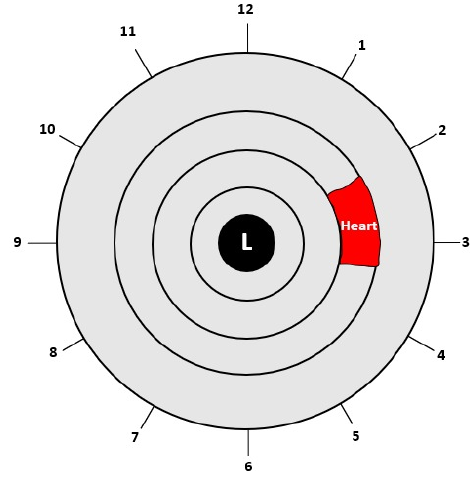
Figure 6. Location of the heart in the left iris [10].